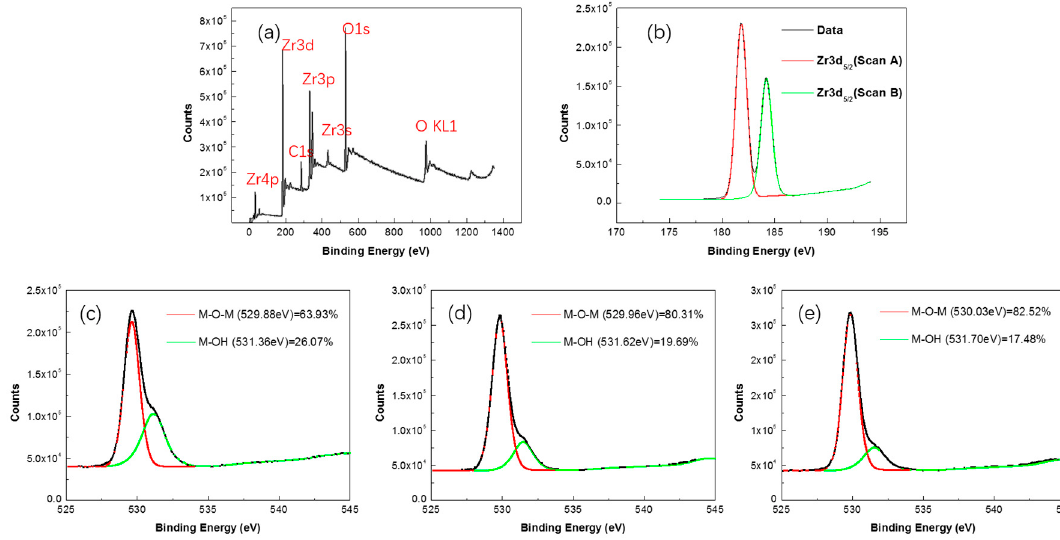
Figure 2. ( a ) X-ray photoelectron spectroscopy (XPS) spectra of ZrO 2 films annealed at 300 °C; ( b ) Zr 3d spectra of ZrO 2 films annealed at 300 °C; ( c – e ) O 1s spectra of ZrO 2 films annealed at 300